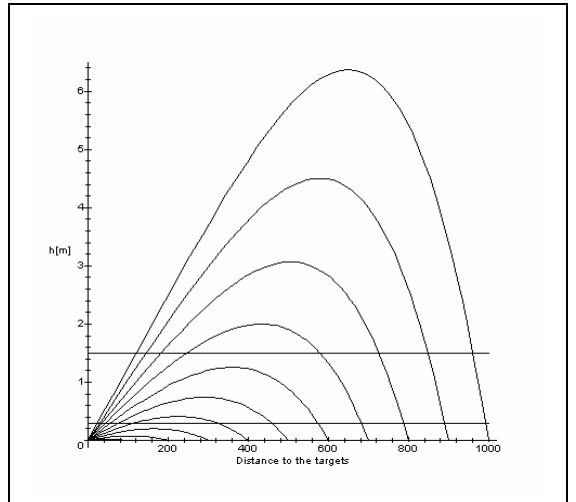
Fig 6. AK 74 bullet trajectories when shooting from 100 m to 1000 m distance. The top line corresponds to the shadow height of the attacking soldier - 1.5 m - and the bottom line to that of the defending soldier - 0.3